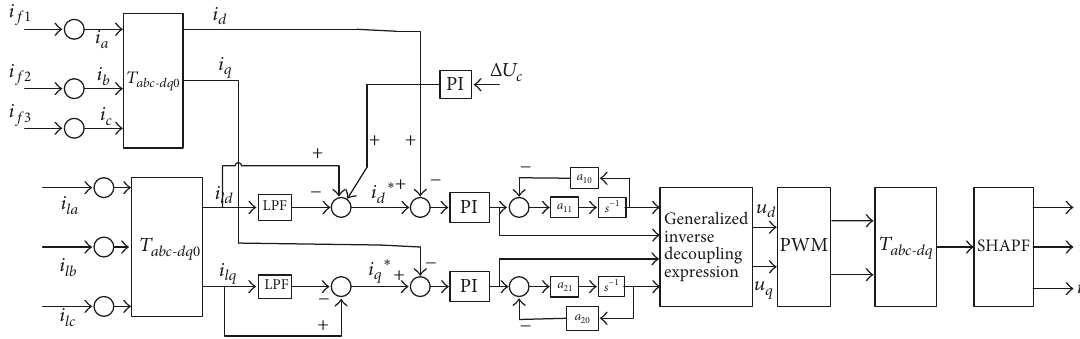
Figure 3: Simulation flow chart of generalized inverse system.